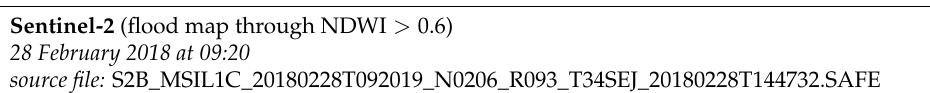
Table 1. Reference datasets over 2018’s flood event in Thessaly. Copernicus EMS (COSMO-SkyMed) 28 February 2018 at 04:20 source file: EMSR271_02FARKADONA_01DELINEATION_MAP_v1_vector.zip Sentinel-2 (flood map through NDWI >